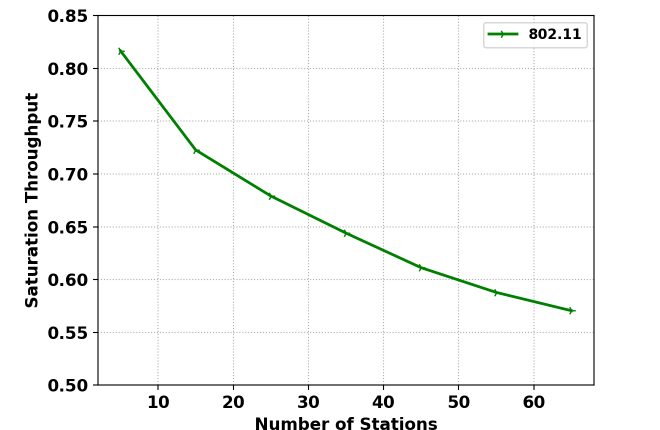
Figure 4. Simulation of IEEE